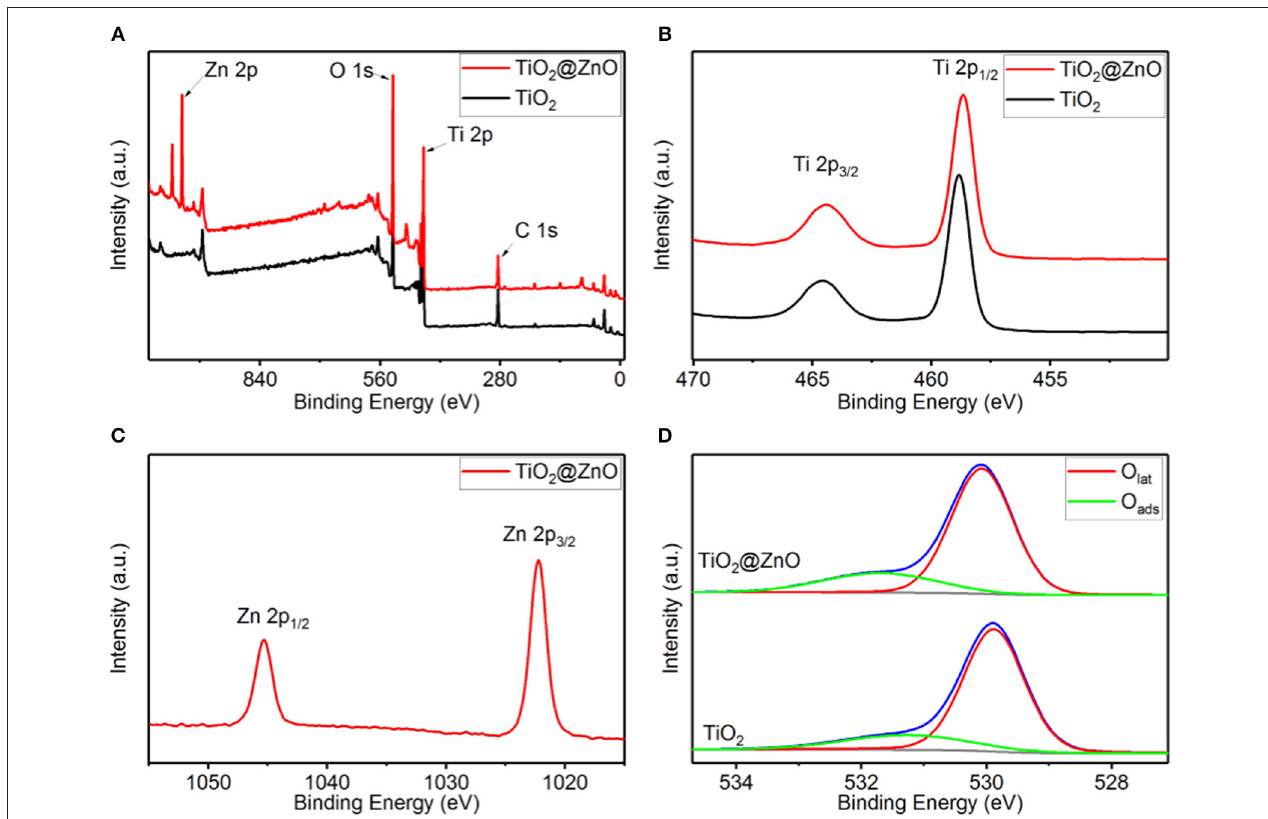
FIGURE 2 | X-ray photoelectron spectroscopy (XPS) spectra of pristine TiO 2 and TiO 2 @ZnO nanotubes. (A) Survey spectrum, (B) Ti 2p, (C) Zn 2p, and (D) O 1s.